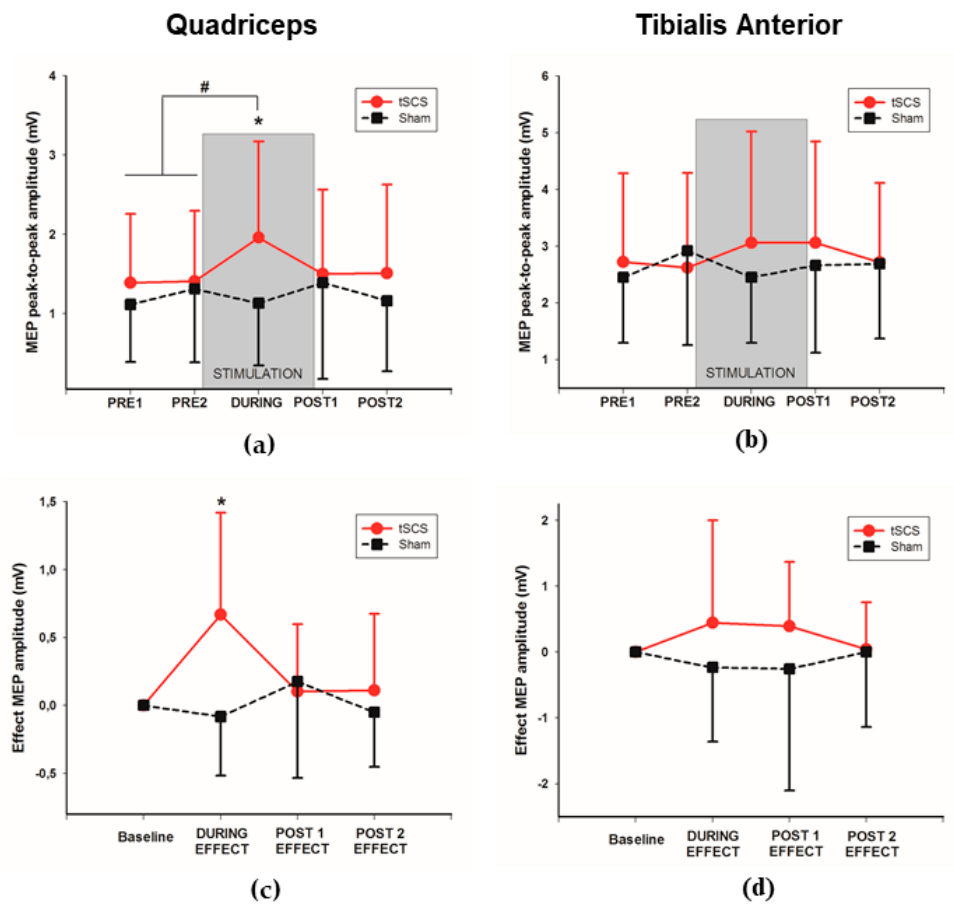
Figure 3. MEP peak-to-peak amplitude: ( a ) MEP of quadriceps muscle at each evaluation time; ( b ) MEP of tibialis anterior muscle at each evaluation time; ( c ) change obtained in MEP of quadriceps during and after tSCS respect to baseline; ( d ) change obtained in MEP of tibialis anterior during and after tSCS respect to baseline. * p ≤ 0.05 when compared to sham-tSCS; # p ≤ 0.05 when compared from baseline.